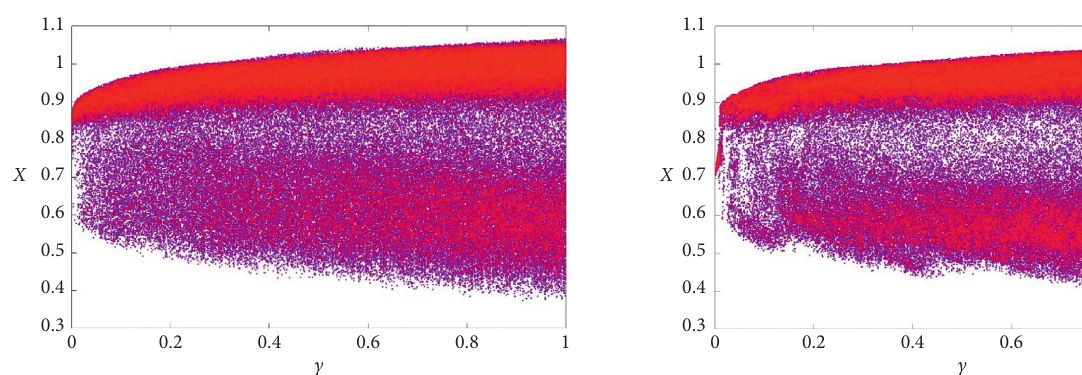
Figure 14: Bifurcation diagram of system (7) for θ � 1 . 30 and η � 0 . 01 with the blue plots showing the forward continuation (increase the parameter 0 ≤ c ≤ 1) and the red plots showing backward continuation.